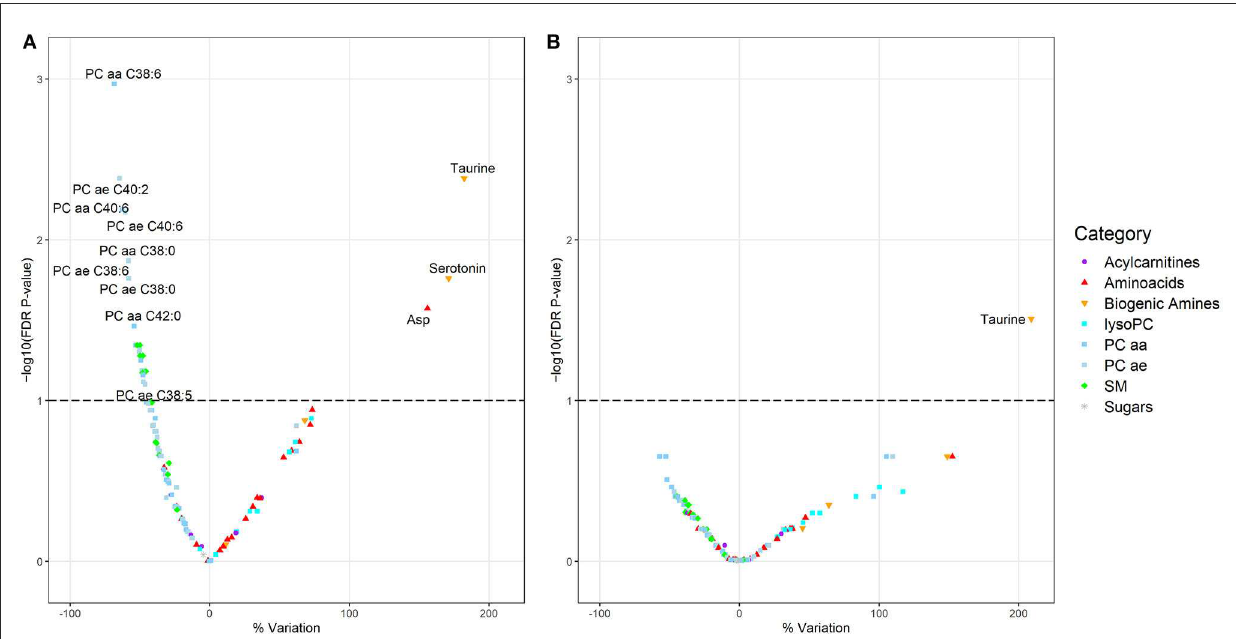
FIGURE1 (A, B) Volcano plots showing the results of the Tobit linear regression models considering the metabolites (dependent variables) in relation to night shift work: current vs. never night shift workers (A) and former vs. never night shift workers (B) . The models are adjusted for BMI, age, plate, and smoking habit. Each dot represents a metabolite and is displayed based on the percentage variation of its concentration (x-axis) vs. the negative logarithm (base 10) of the FDR p -value (y-axis). The dashed line represents a FDR p -value equal to 0.1.